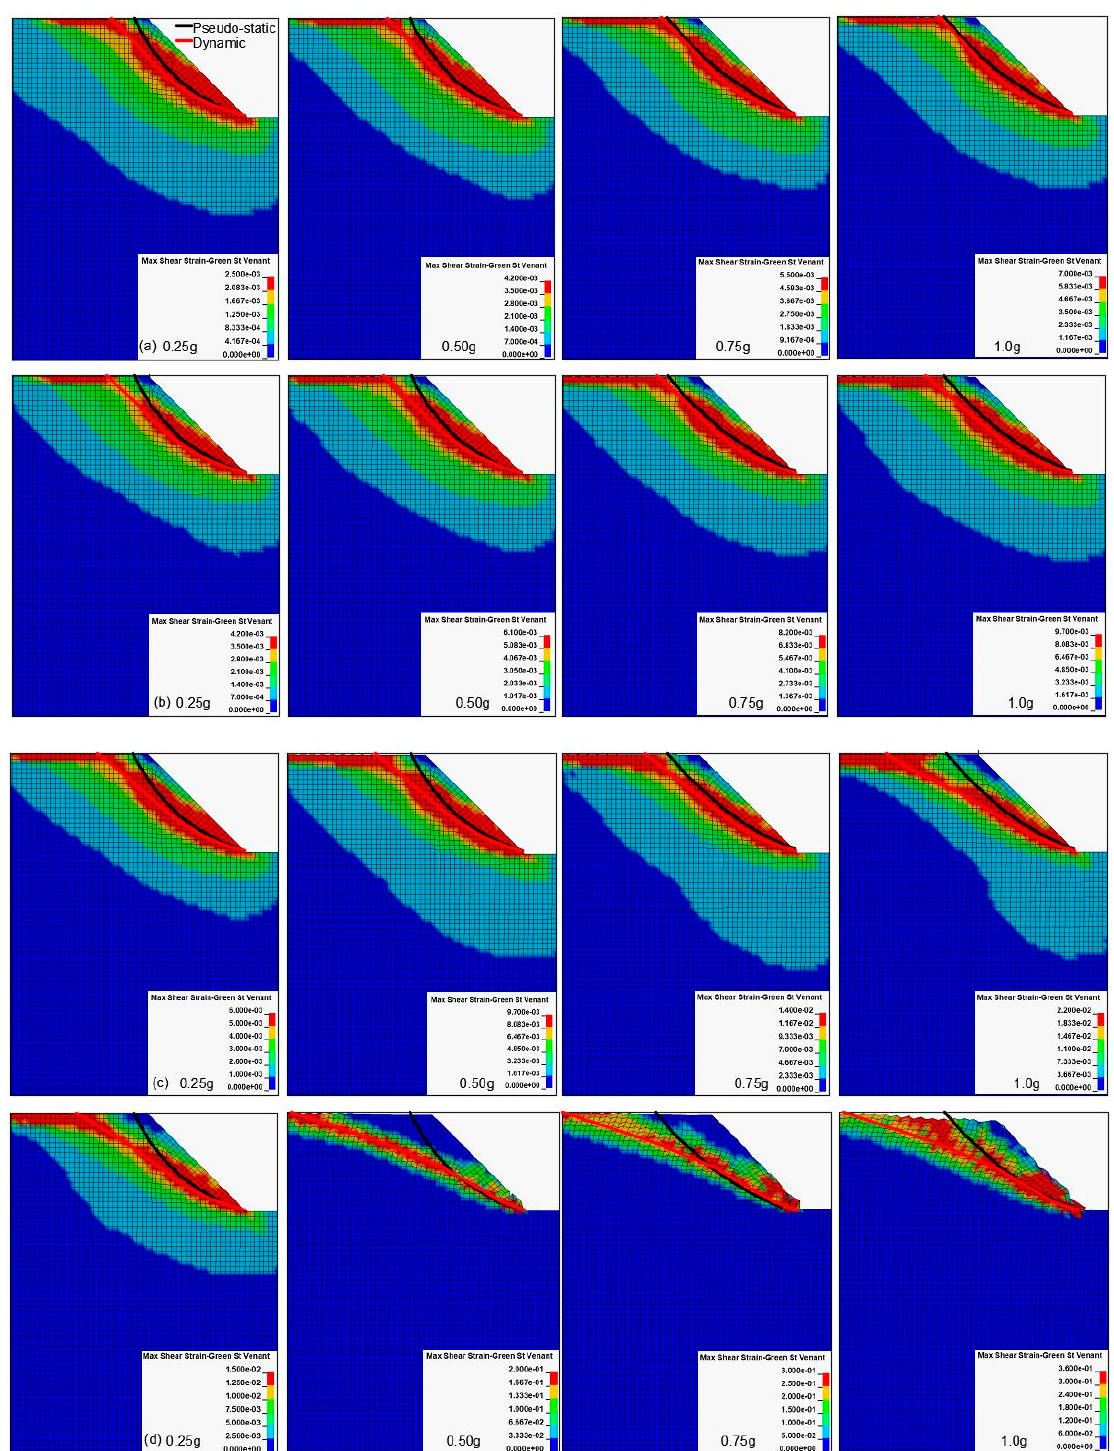
Figure 8. Effect of input motion on the slope failure surface for Case 09: ( a ) Whittier Narrows; ( b ) Northridge; ( c ) Ofunato; ( d ) Kobe.